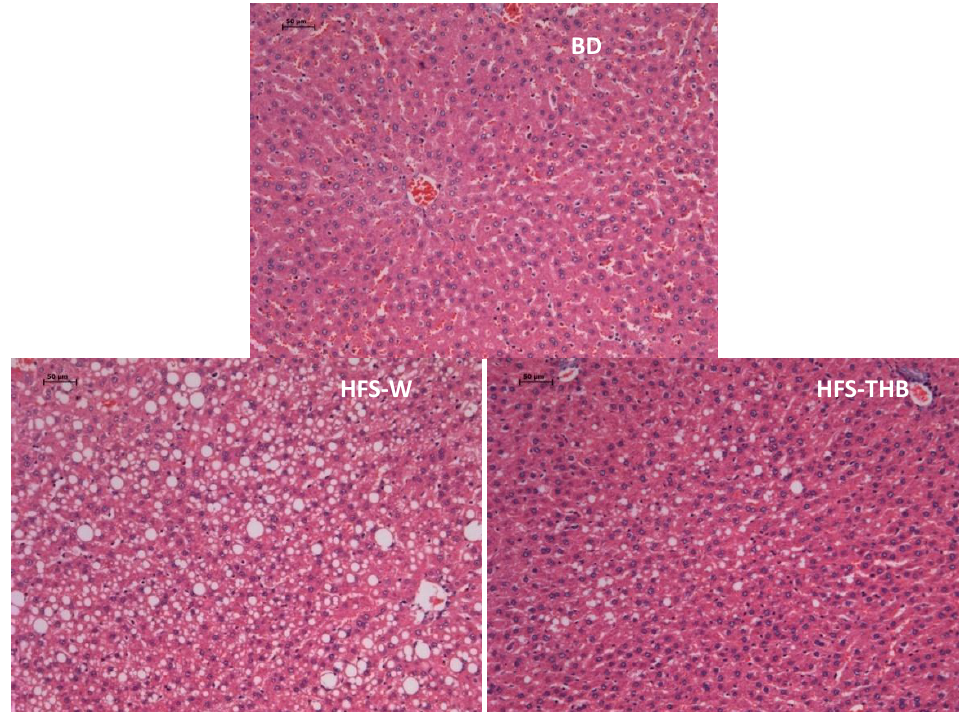
Figure 2. Histological features inon liver of in experimental rats (100×). Liver tissue of SD rats was stained with hematoxylin and